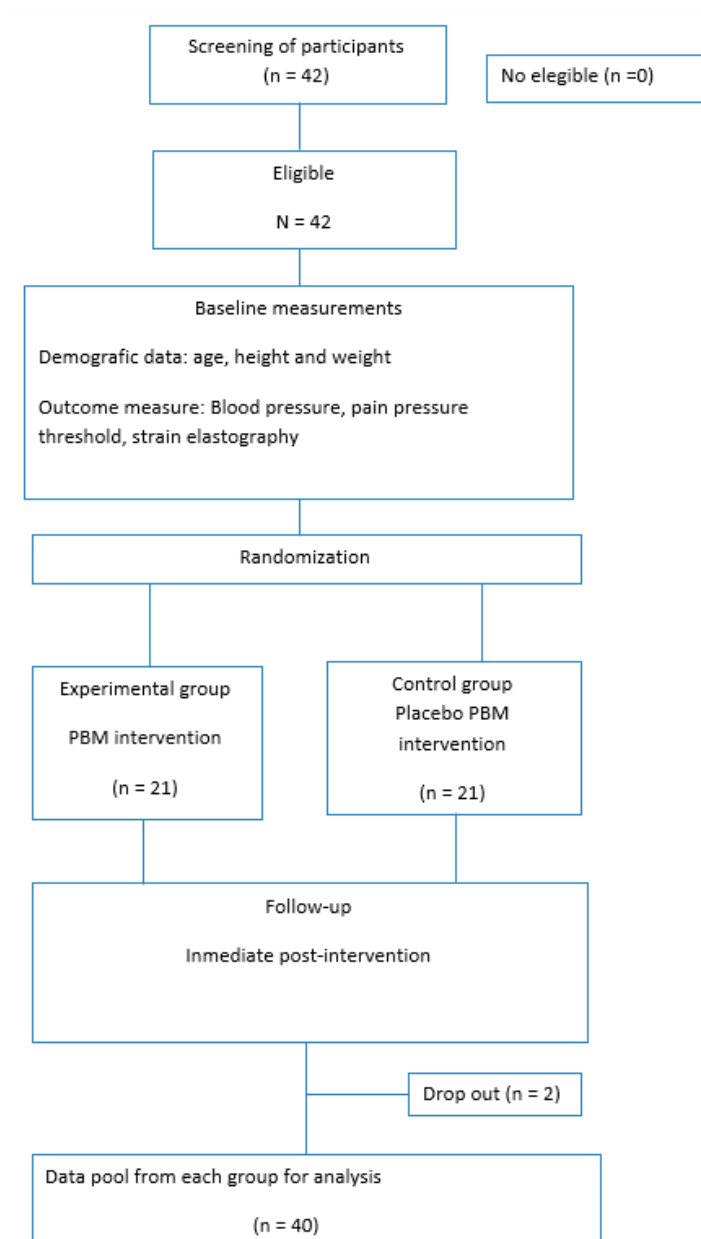
Figure 3. Assessment process.